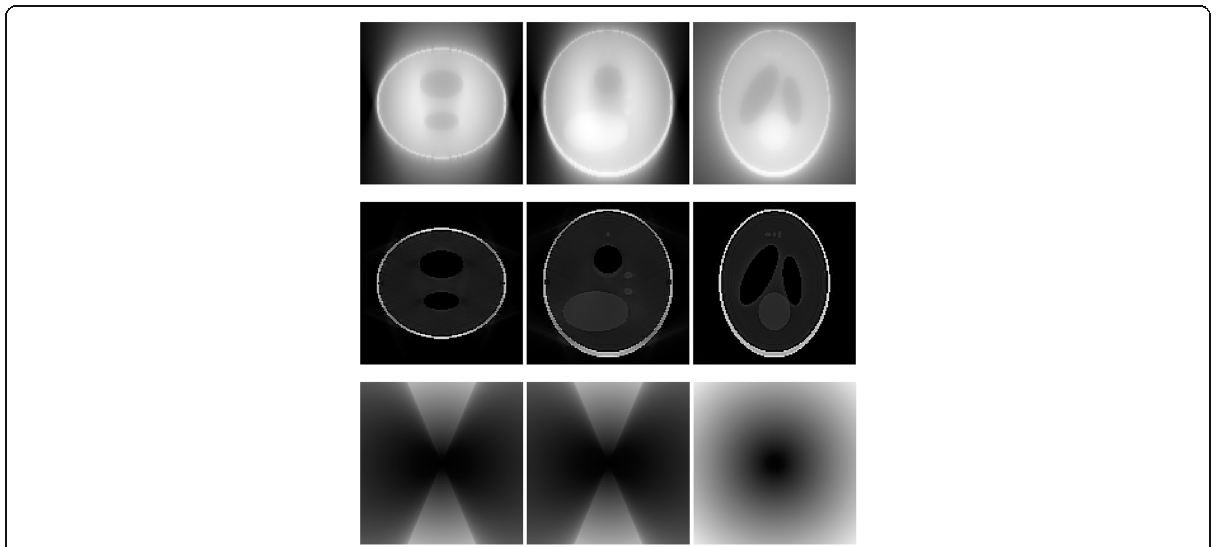
Fig. 15 Image reconstruction using non-TOF algorithm for the case of ψ = π /8. Row 1 : TOF backprojection. Row 2 : Final reconstruction. Row 3 : Tomographic filter H . Three central orthogonal cuts are shown for each